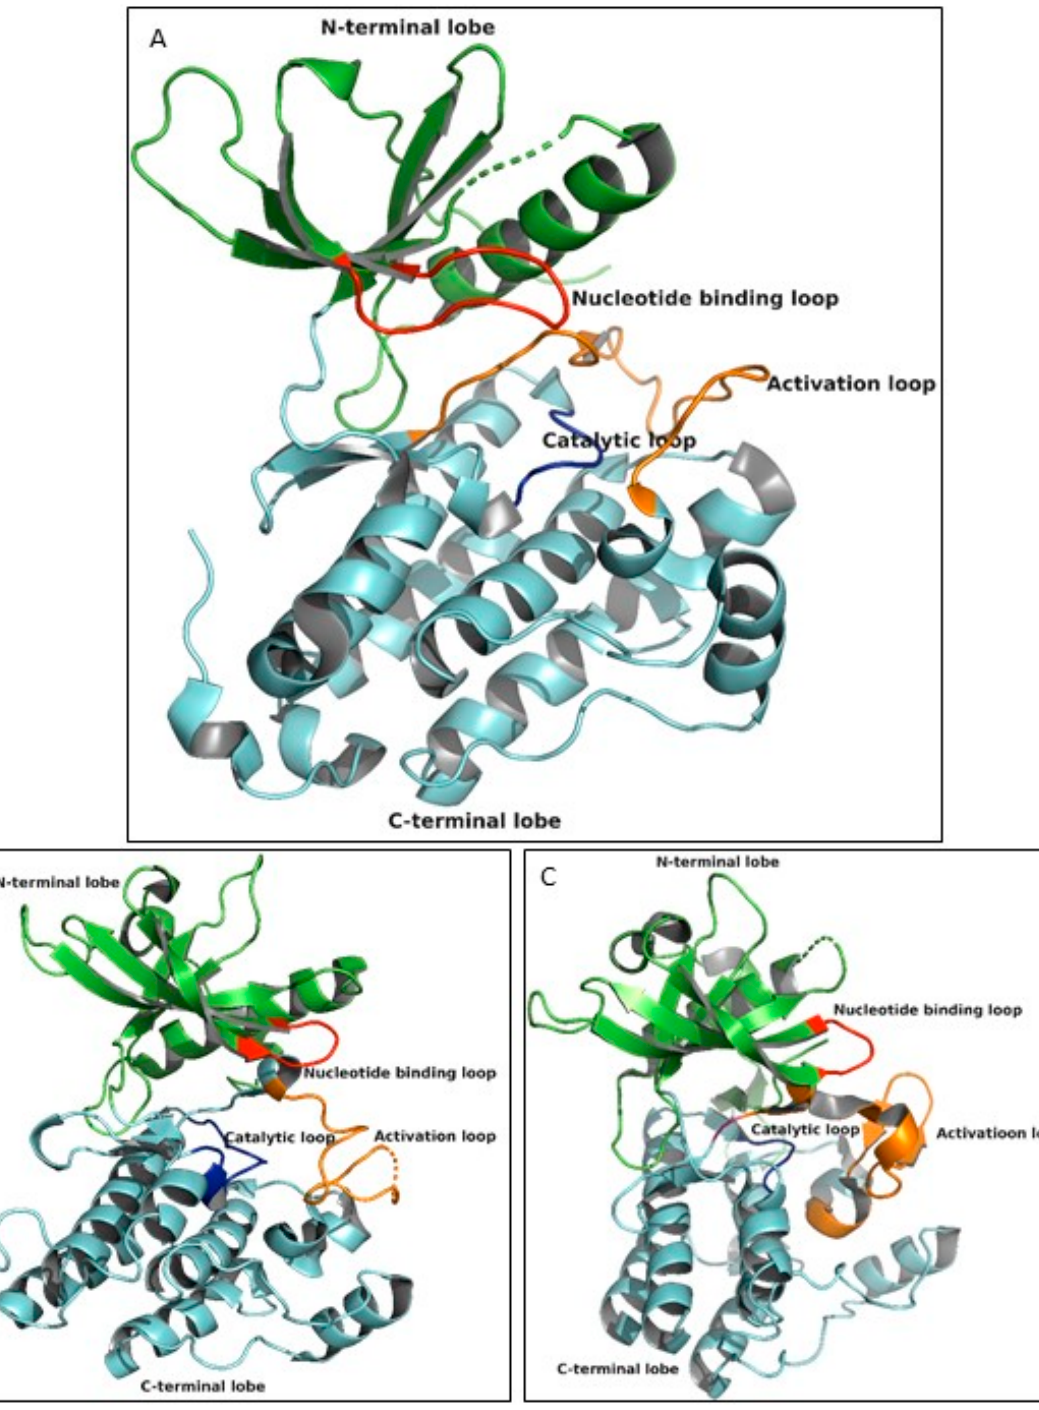
Figure 2. Overall folding of EGFR protein kinase ( A ); VEGFR-2 protein kinase ( B ) and FLT-3 protein kinase ( C ).